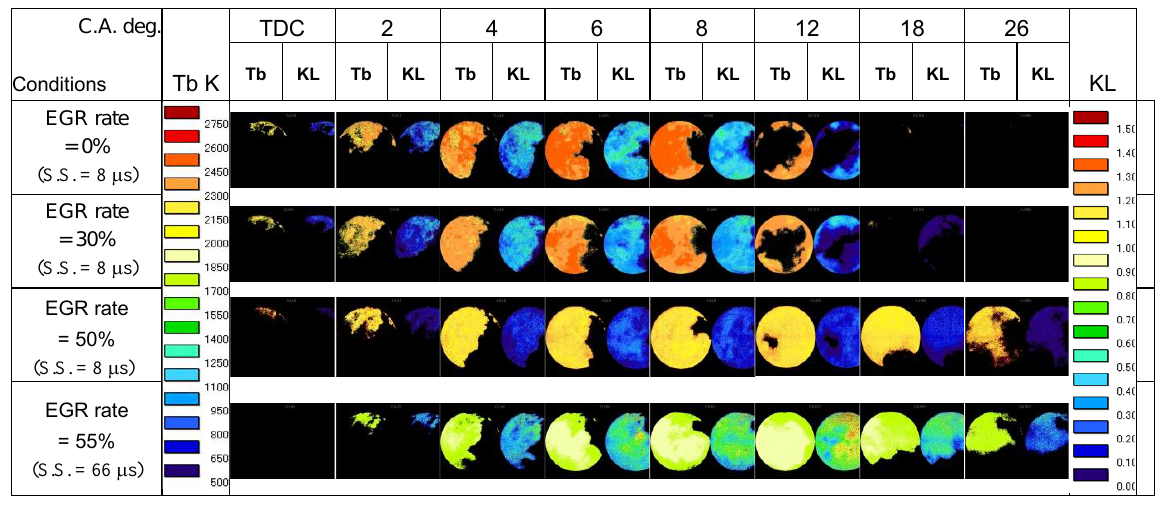
Fig. 13. Distribution images of flame temperature Tb and KL factor by changing EGR rates